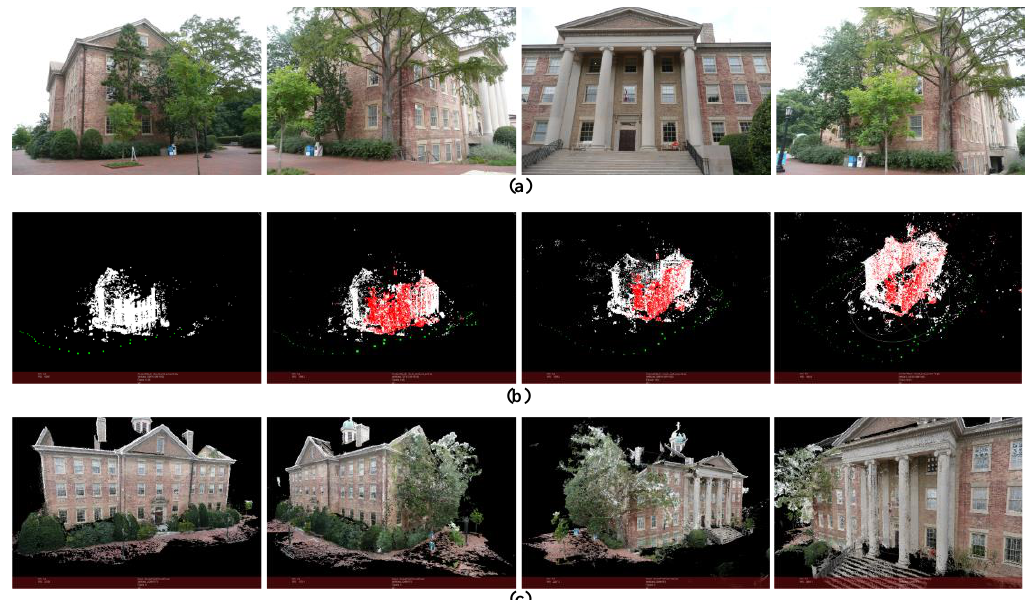
Figure 18. Reconstruction result of botanical garden. ( a ) Part of the images used for reconstruction; ( b ) Structure calculation of image queue SfM (green points represent the positions of camera); ( c ) Dense point cloud of the scene.